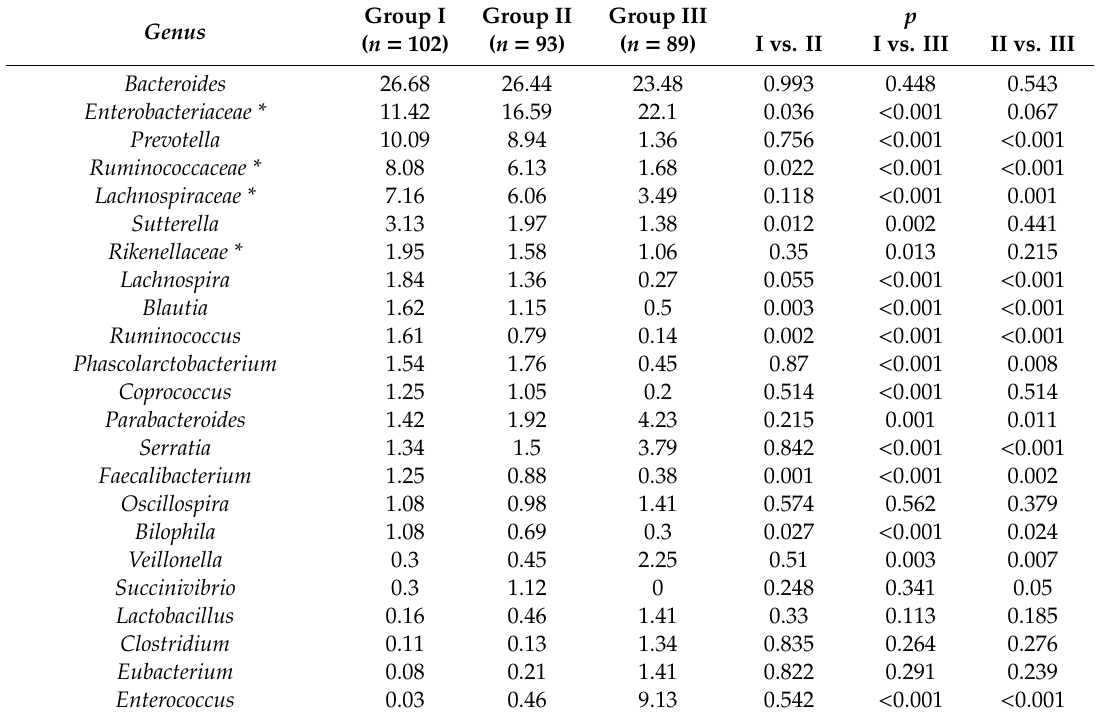
Table 4. Comparison of the mean relative abundance (%) at genus level C. di ffi cile- non-colonized (group I), colonized (group II), and diarrhea with C. di ffi cile (group III).